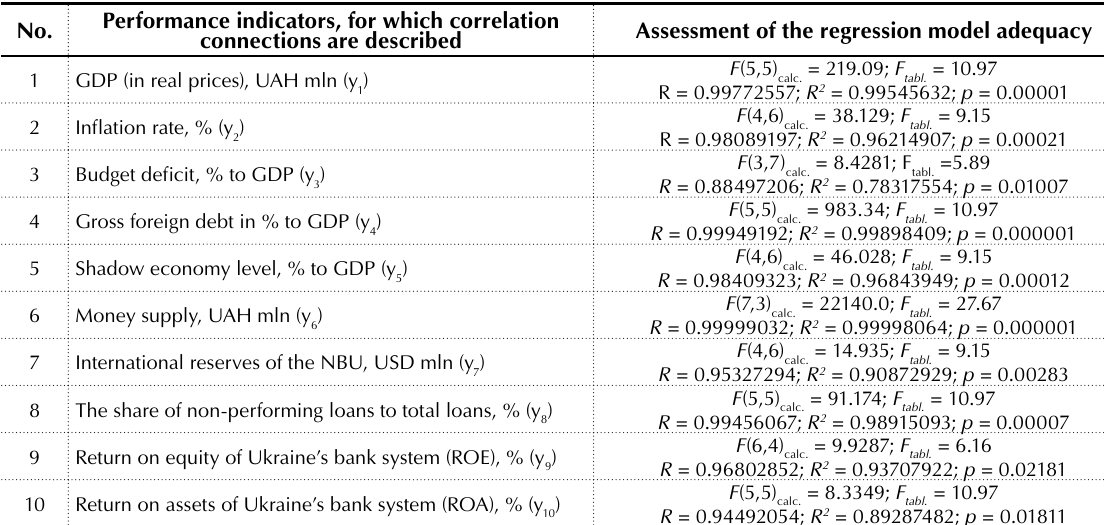
Table 2. The results of the correlation regression analysis of the indicators of financial and economic security of the state as influenced by foreign banking indicators and verification of the regression model